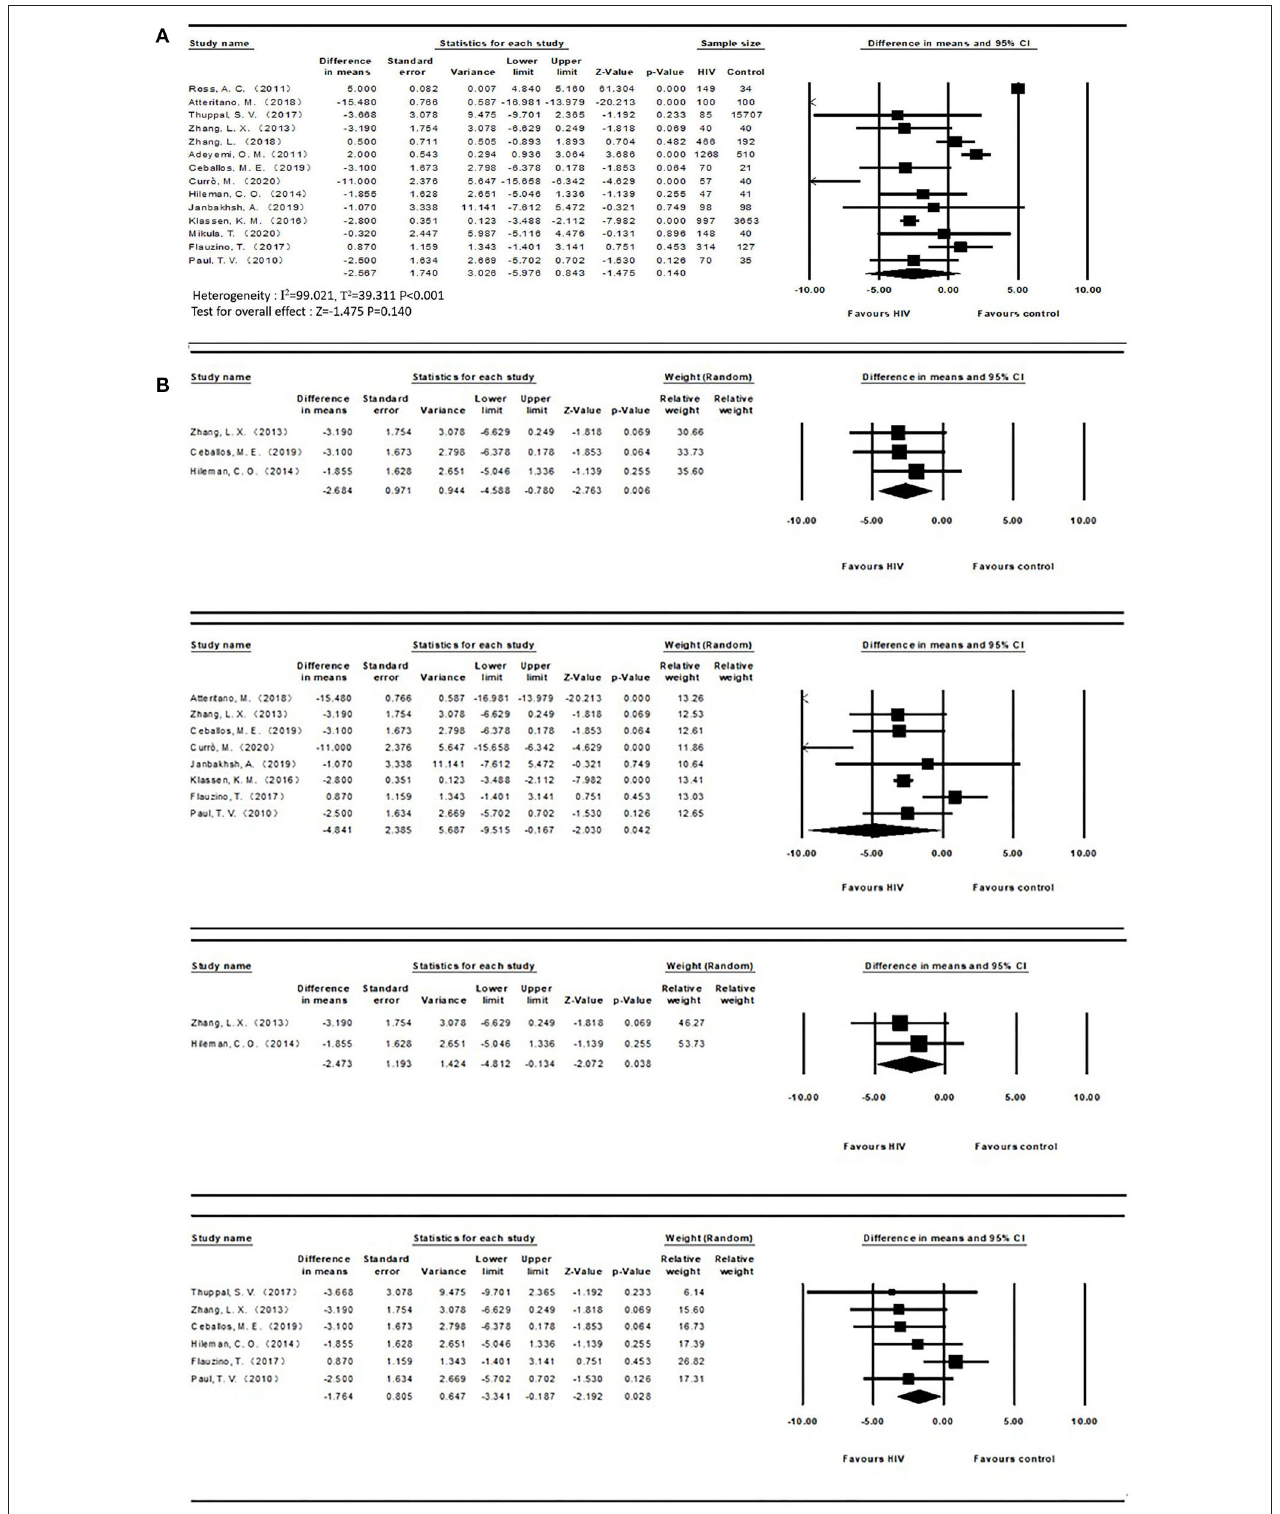
FIGURE 3 | (A) Vitamin D levels in HIV and control groups; (B) Subgroups of vitamin D levels (ART-naïve, Latitude bottom) between both groups.